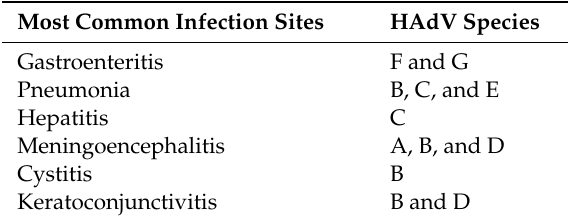
Table 1. Common associations between general infection sites and Adenovirus (HAdV) species. Other HAdV species may also occur at the site of infection. Many HAdV species show great variability in their tissue